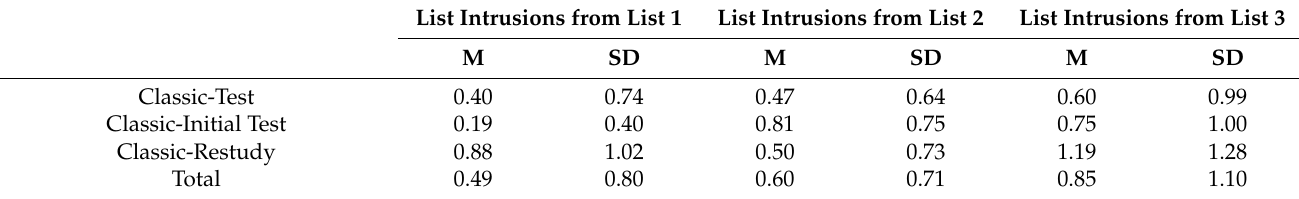
Table A2. M and SD over the number of list intrusions from the previously occurring lists, respectively, in the fourth block’s interim